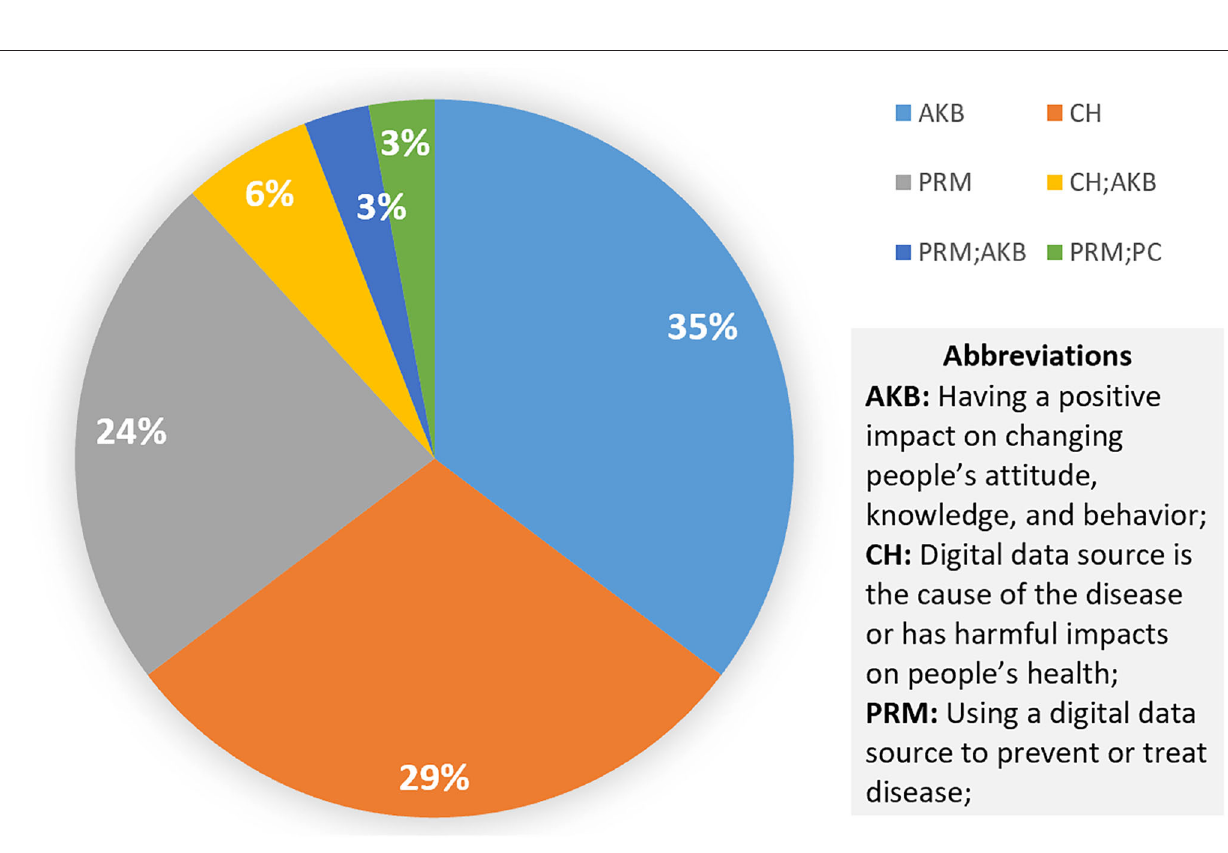
Frontiers in Public Health |